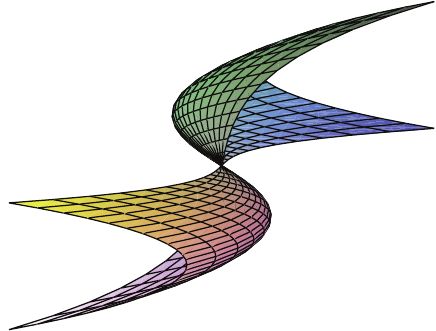
Figure 2: The surface of Enneper of the 3rd kind.